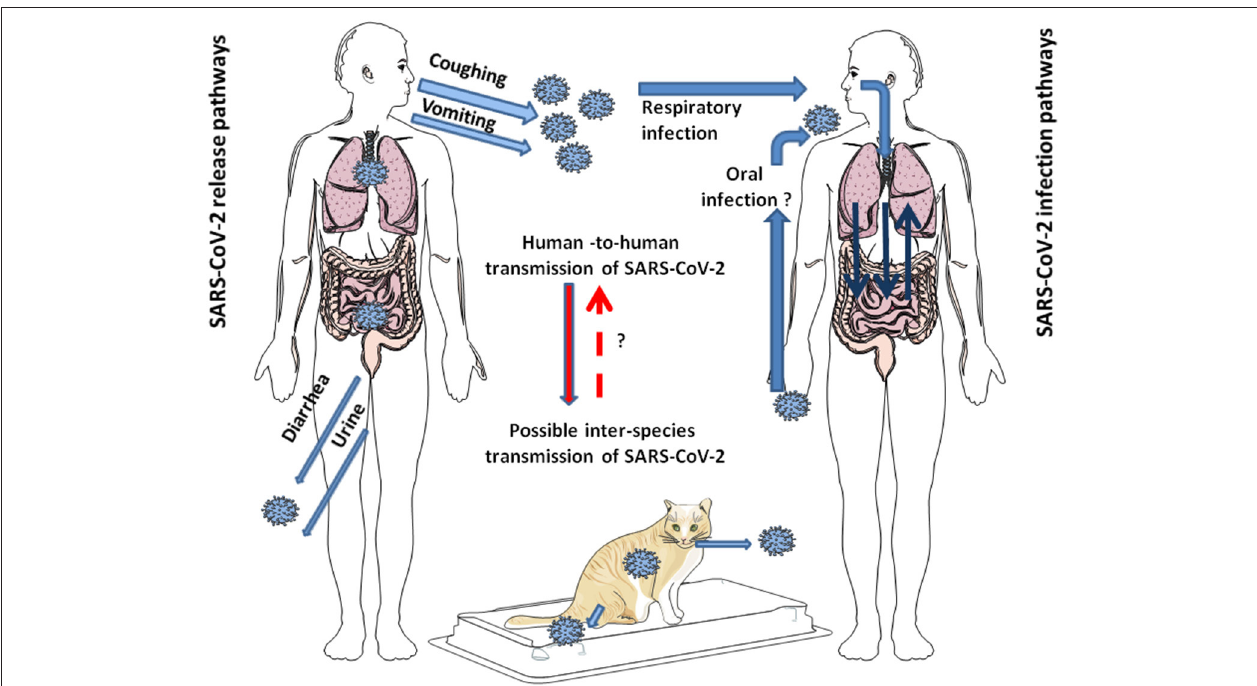
FIGURE 1 | Schematic representation of the modes of transmission of SARS-CoV-2 among humans. SARS-CoV-2 is released from infected individuals by coughing, vomiting, and through diarrhea and urine. Airborne is considered the primary mode of human-to-human transmission of SARS-CoV-2. After infection of the respiratory tract, the virus can leave the lungs via circulation to induce secondary foci in other organs, including GIT. Whether SARS-CoV-2 can directly infect the GIT by the oral route in humans seems possible since it is stable at acidic pH, but it is still under debate. Additionally, it has been shown that SARS-CoV-2 can jump back and forth between humans and animals. This has been largely reported with minks. In pets, such as cats, human-to-cat transmission of SARS-CoV-2 and cat-to-cat respiratory transmission of SARS-CoV-2 was demonstrated, not yet for cat-to-human transmission of